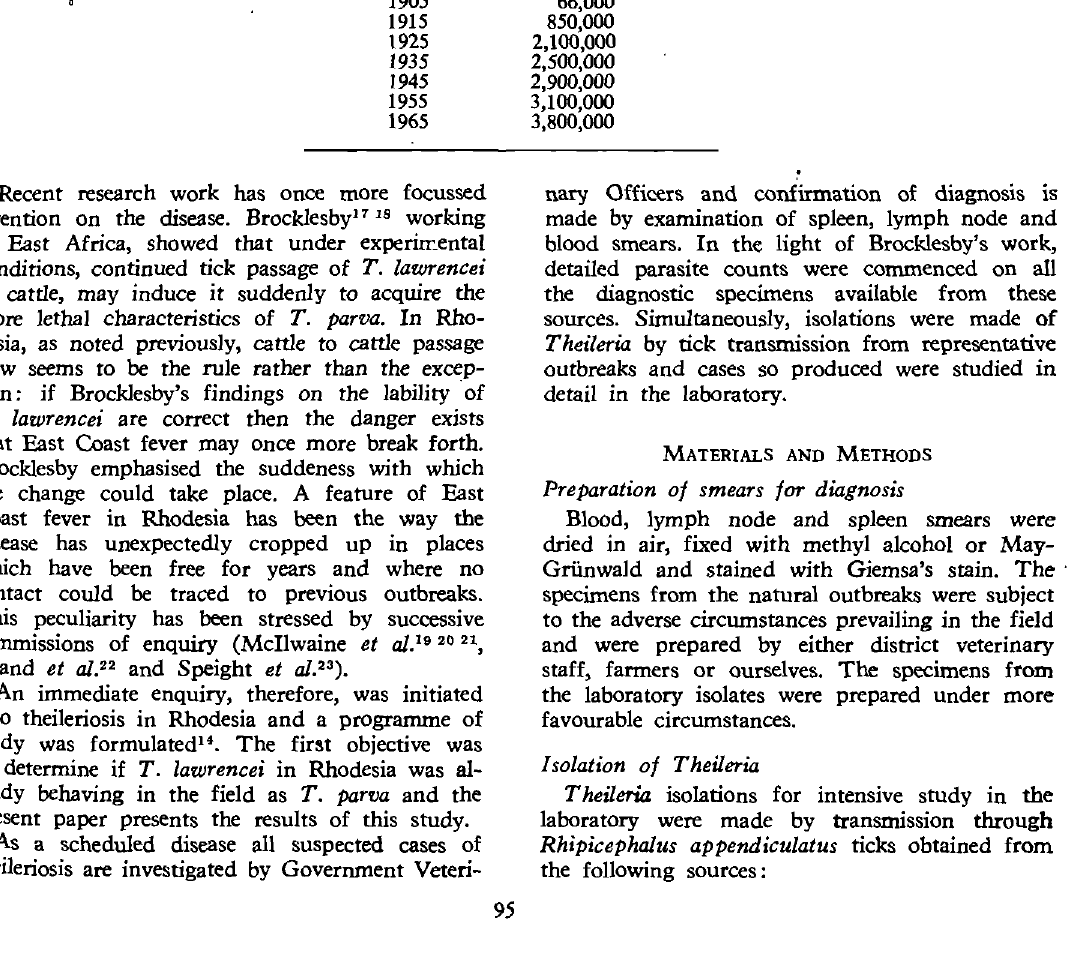
TABLE 2.--CATTLE POPULATION IN